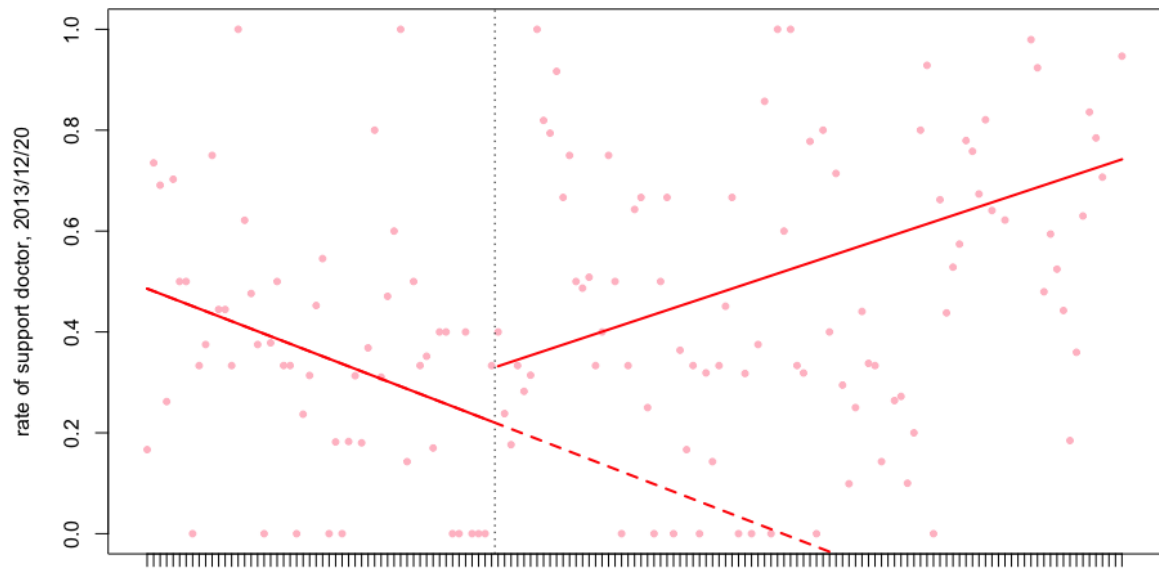
Figure 2. “Support doctor” proportion of public online opinion over time. Trend lines show slope change after lagged intervention date. Vertical dash line shows lagged intervention date of policy 2, Dec 20, 2013.